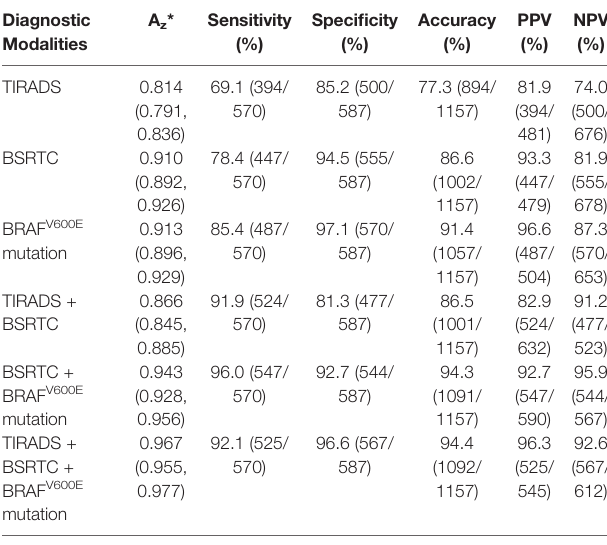
TABLE 4 | Comparison of the diagnostic performance of different modalities for discrimination between benign and malignant thyroid